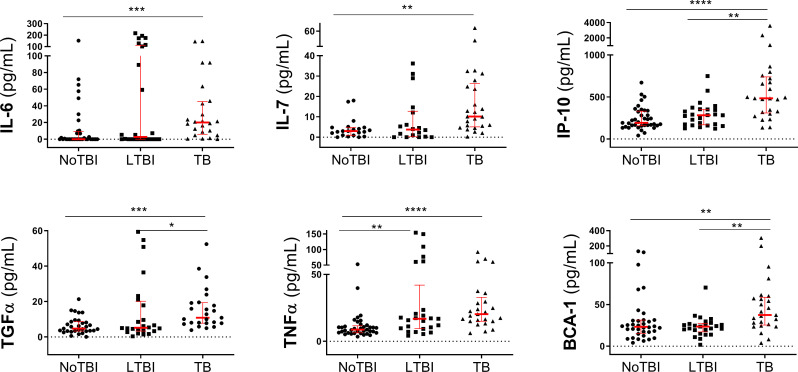
Concentration of protein markers detected in serum samples.The horizontal bars represent the median and the interquartile range. Differences between study groups were calculated using a Kruskal-Wallis test followed by a Dunn´s test corrected for multiple comparisons. Significant differences between groups are expressed as: * p < 0.05; ** p < 0.01; *** p < 0.001; ****p < 0.0001.